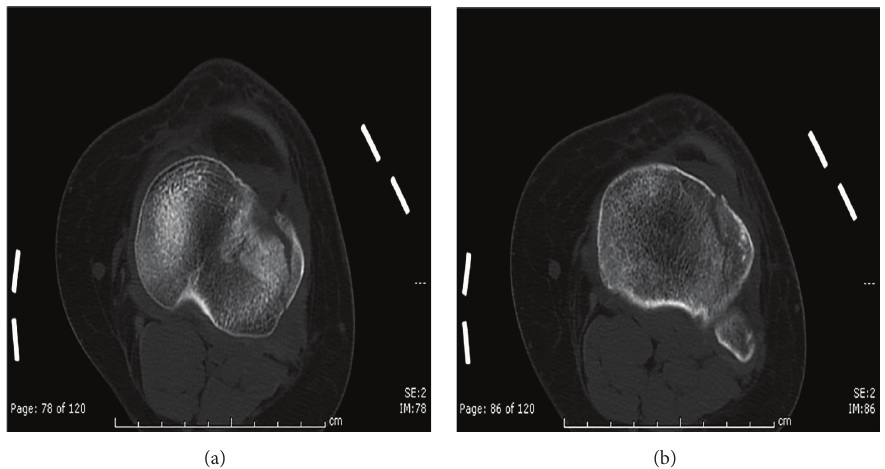
Figure 2: Initial CT scans of left tibia showing fracture of lateral tibial condyle.